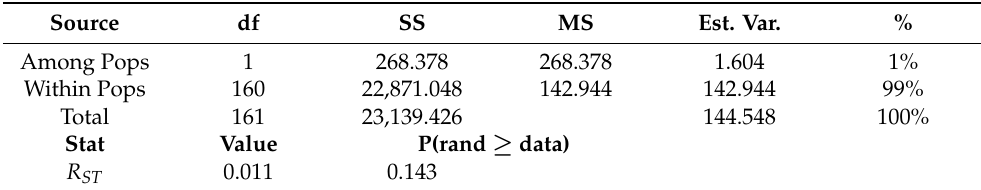
Figure 3. Graphical translation of membership probabilities to the five clusters. The colors of the bars correspond to the clusters in Figure 1. The vertical axis gives membership probability from 0 to 1. All isolates except isolate 55 are assigned with 100% certainty. The black vertical line separates Danish and Iranian isolates. The clusters are almost evenly distributed between Denmark and Iran except cluster 3 (yellow), which is only found in Iran. All isolates were susceptible to azoles, echinocandins, and amphotericin B and were FKS1 (hot-spot) wild-type (Table S3). Thirty-eight isolates were ERG11 wild-type, and